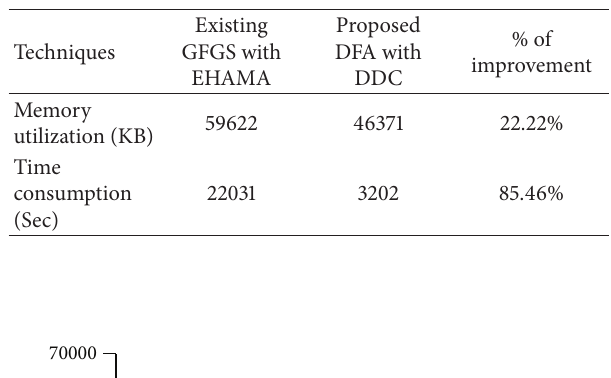
Table 3: Proposed approach metric comparison.